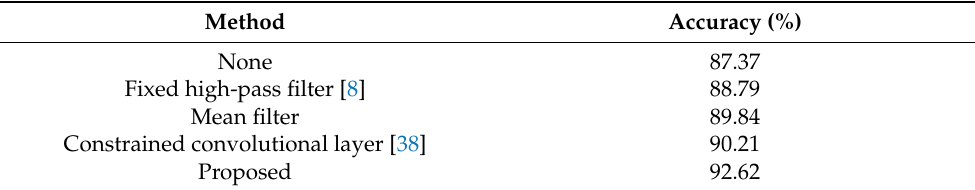
Table 4. Comparison of model level identification accuracy of different preprocessing methods.